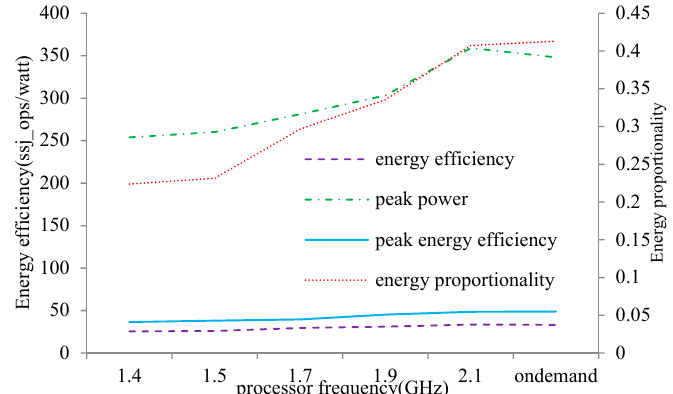
Figure 17. Server #1 energy efficiency and proportionality under different frequency scaling configurations.